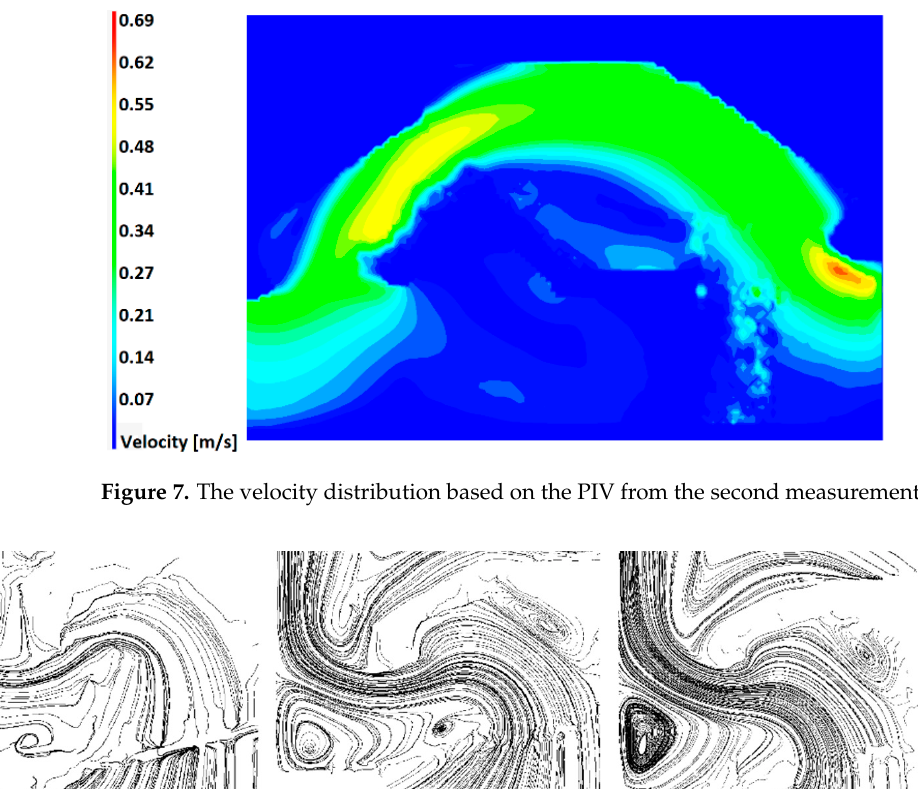
Figure 6. The velocity distribution based on the PIV from the first measurement area [22]. The velocity distribution obtained from the second measurement area is shown in Figure 7. The size range of velocity is from 0 to 0.69 m ∙ s − 1 due to the better clarity of the figure. At setting 1, the velocities reach a maximum value of 0.55 m ∙ s − 1 but a local increase in velocity can be observed at the end of the second baffle, where the velocity is 0.68 m ∙ s − 1 .